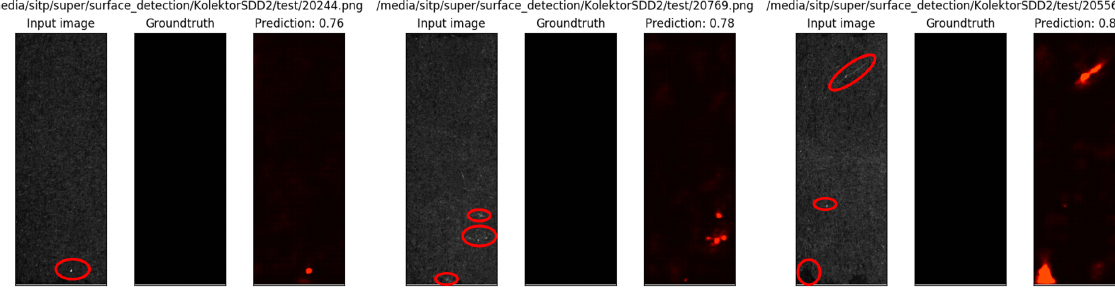
Figure 14. Examples of FP in KolektorSDD2.